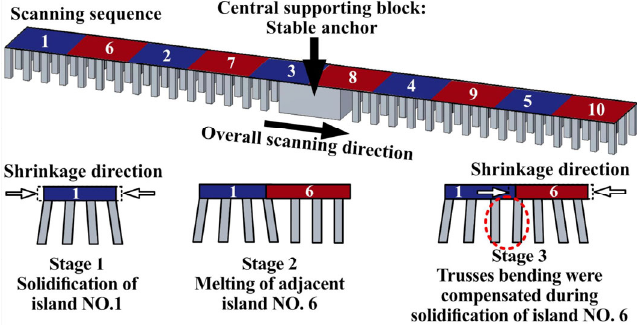
Figure 24. Schematic of the chessboard scanning strategy.